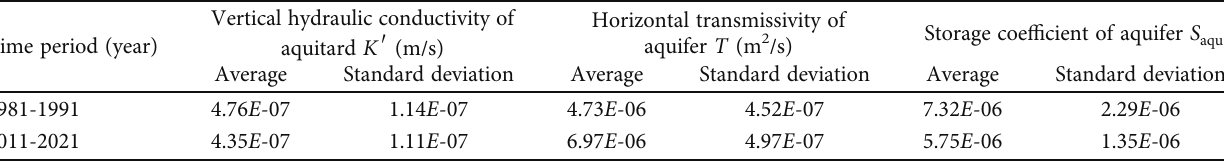
Table 3: Derived parameters from the mixed fl ow model.